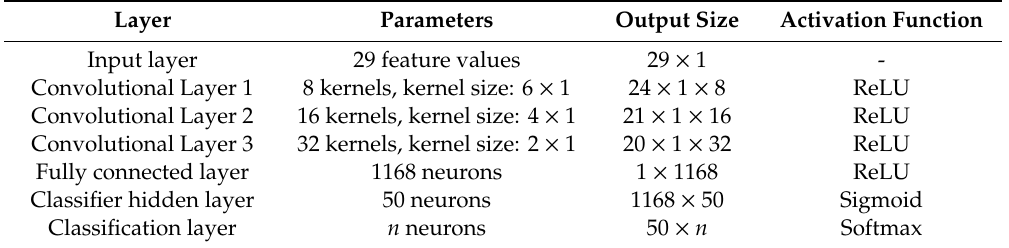
Table 3. Specific setting parameters of the shallow information fusion-convolutional neural network (SIF-CNN). Layer Parameters Output Size Activation Function